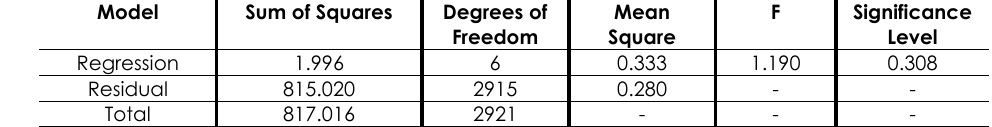
Table 15. Table of variance in the model established to determine whether there is a day effect on